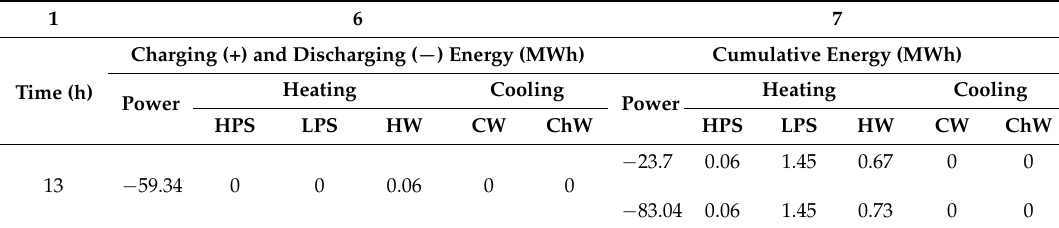
Table A14. TriGenSCA after iteration from 13 to 24